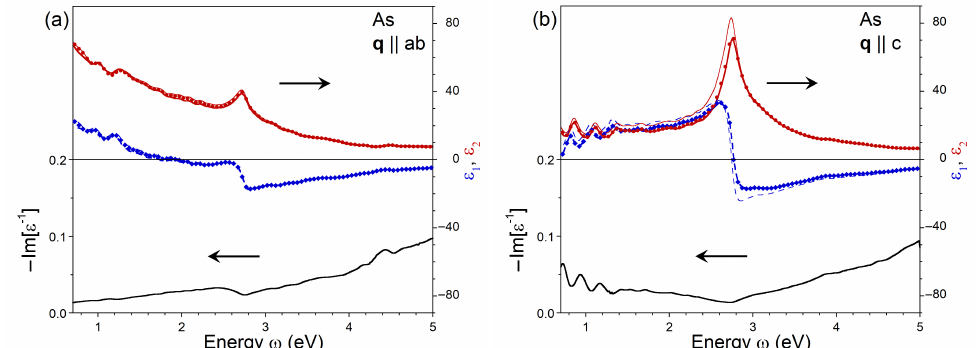
Figure 3. Imaginary (red dashed line) and real (blue solid line) parts of dielectric function in As calculated at q pointing in ( a ) ab plane and ( b ) c direction obtained with inclusion of the local-field effects and the RPA kernel. The respective loss function, − Im [ (cid:101) − 1 ] , is shown by black solid line. Imaginary and real parts of the RPA dielectric function evaluated without inclusion of local-field effects are shown by thin red dashed and thin blue solid lines, respectively. The parts of dielectric function obtained with inclusion of both the local-field effects and ALDA kernel are shown by filled diamonds and circles.